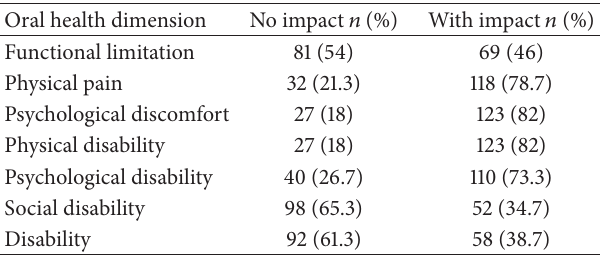
Table 1: Distribution of patients treated in the Periodontics section at Dental Specialty Centres (Centros de Especialidades Odon- tol´ogicas), Juiz de Fora, 2013, according to the frequency of impact per OHIP-14